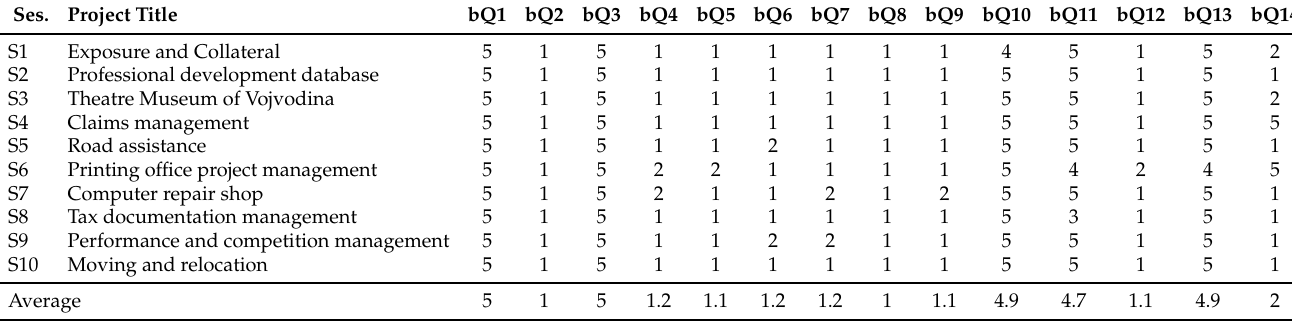
Table 6. Development sessions evaluation